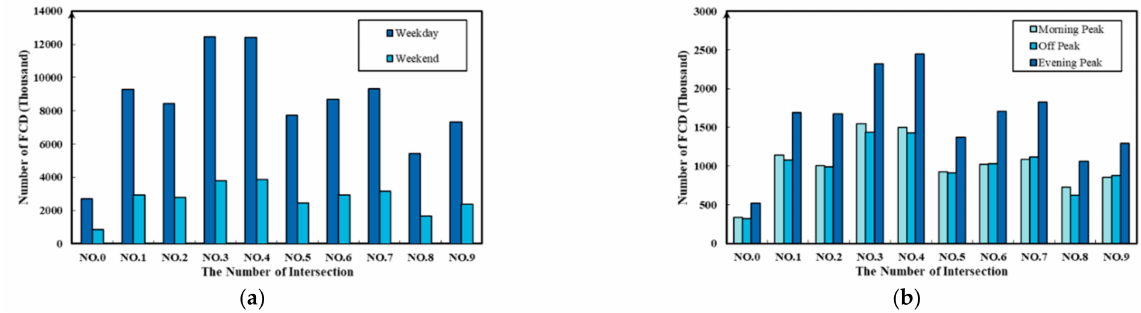
Figure 10. The order of FCD distribution ( a ) Hourly and ( b ) daily distributions of traffic flow at the selected